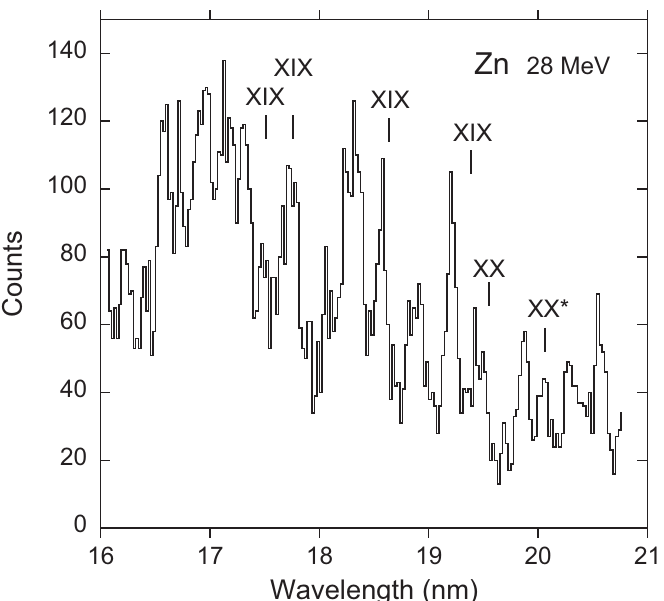
Figure 8. Beam-foil data obtained at an ion beam energy of 28 MeV, with an observation 2 mm downstream (roughly 0.2 ns after excitation), slits of 0.12 mm, and line width of 0.09 nm: This ion beam energy is much lower than the production optimum near 65 MeV [74], which is beyond reach of the Bochum ion accelerator. Moreover, the ion source yields Zn ions at a significantly lower current than has been achieved with some other elements. The most abundant spectrum expected is ZnXVI, while the charge state fraction of interest, Zn 19 + (spectrum ZnXX), is predicted to amount to a few percent at best [74]. The positions of all Zn lines listed by Kelly [76] in the wavelength range depicted are marked, but there are no consistent matches. A suitable indicator whether the proper charge state has been produced is the appearance of prominent lines of singly excited Zn XX, for example, the 3p–3d line at 19.538 nm [76], but that transition shows as a weak and blended line at best. Consequently, the line of interest in ZnXX* must be too weak to observe in this spectrum. There actually is a line at 20.05 ± 0.02 nm that is compatible with the predicted position of 20.039 nm [64], but the line seen is much stronger than the line of interest in ZnXX* could be under the circumstances, suggesting a blend with some stronger, unidentified line. CHIANTI [77] lists very few Zn lines in this wavelength range